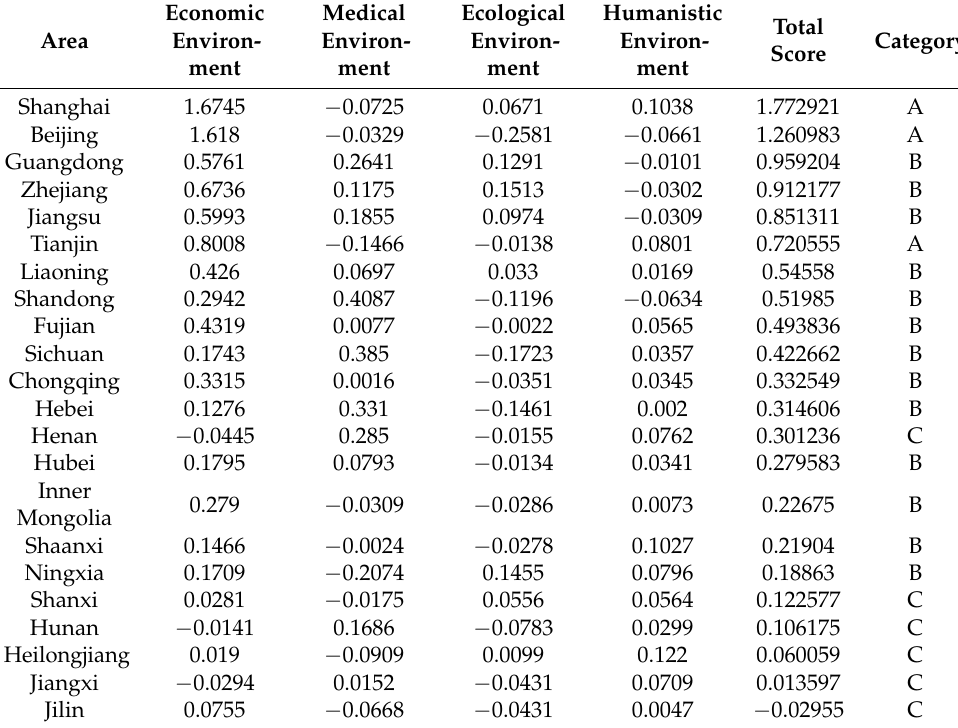
Table A8. Healthy environment scores and classification in